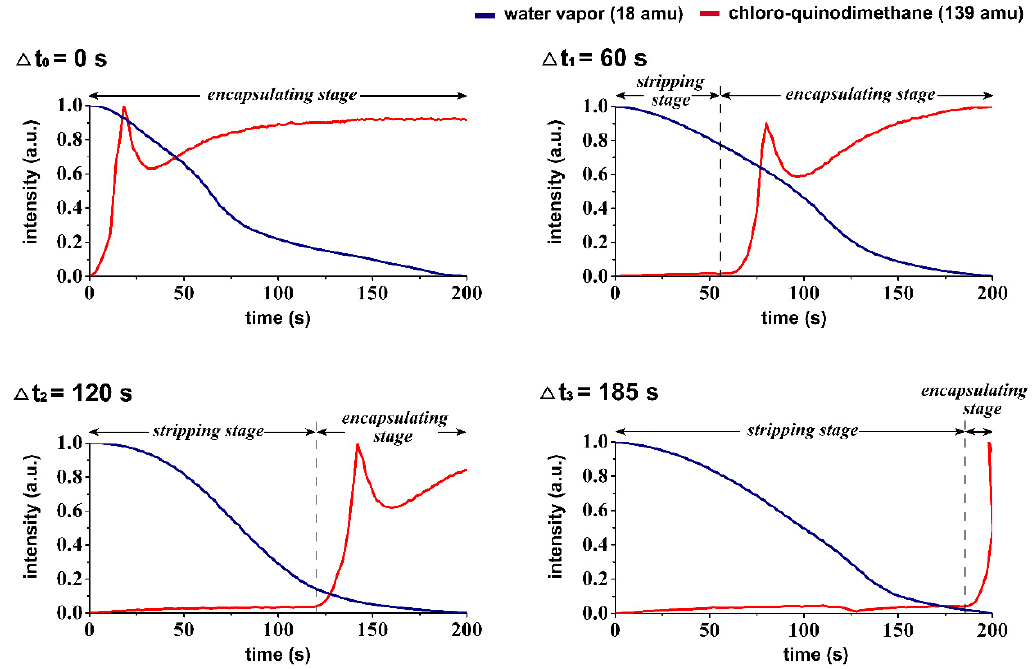
Figure 3. Real-time mass spectrometry analysis of the vapor compositions during the CVSD process showed controllable timing of Δ t 1 , Δ t 2 , Δ t 3 , with corresponding regulations of vapor compositions in the stripping stage and the encapsulating stage.